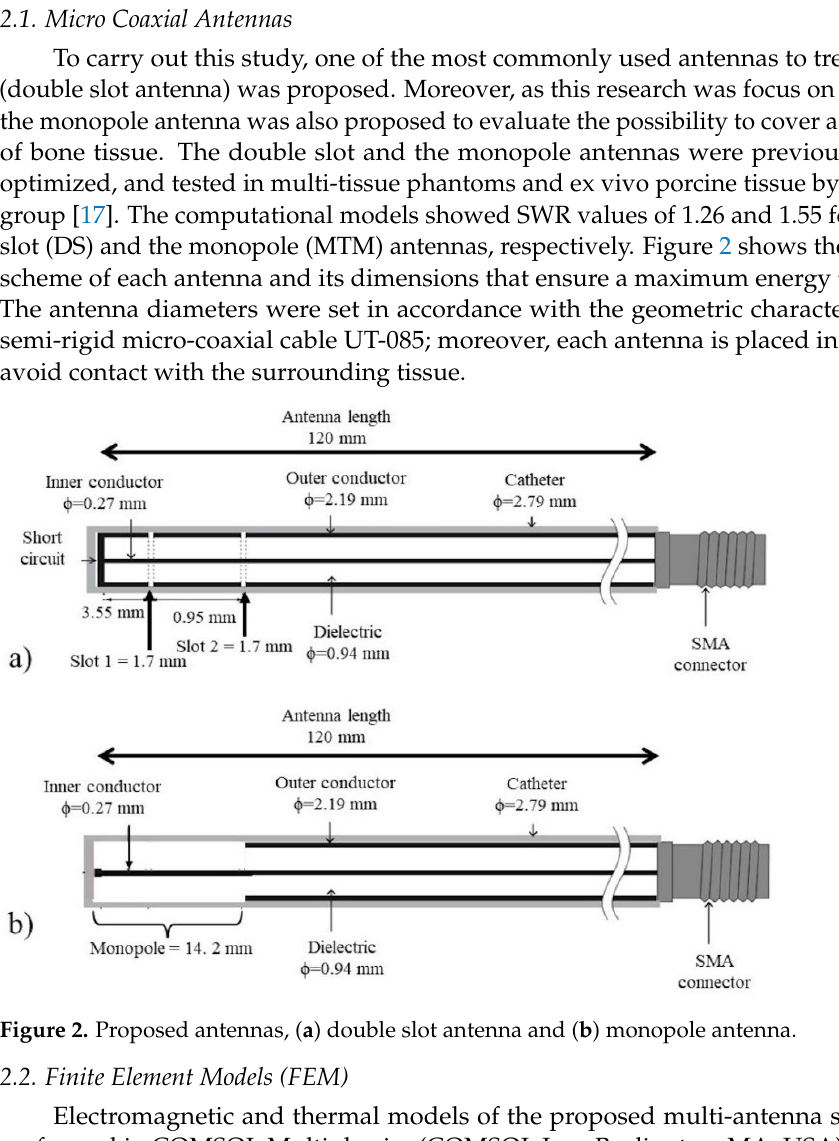
Figure 1. Step by step flow chart that was followed to implement the study.